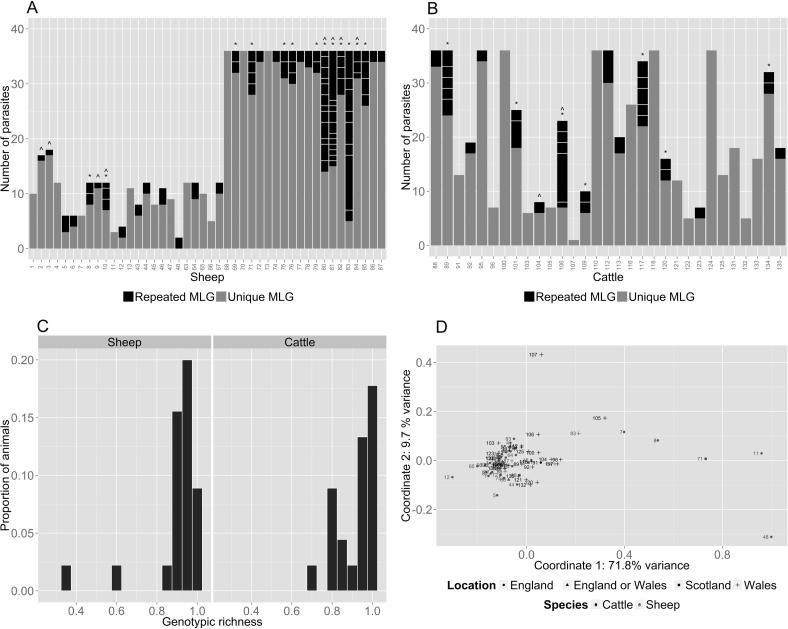
Representation of the number of clonal Fasciola hepatica parasites (those with repeated multilocus genotypes) found within each individual (A) sheep and (B) cattle and shown as a proportion of the total number of parasites genotyped from each definitive host; numbers on the x-axis are individual animal identifiers; ∗ indicates that more than one clone set was found in an individual host, the bar is split to distinguish the number of parasites within each clone set; ^ indicates that clone sets are shared between hosts. (C) Histogram displaying the genotypic richness values within each definitive host, separated into sheep and cattle. Genotypic richness (R) is a measure of genetic diversity and is calculated as R = (G − 1)/(N − 1) where G = the number of genotypes identified in each host and N = the number of parasites genotyped; each histogram bar is of width 0.05 with the bar centred over the upper limit. (D) Principal Component Analysis for pairwise FST values between the parasites of each definitive host. Each data point and its corresponding number represent an individual animal, and the shape and colour of the symbol represent the location and species of that animal, respectively.